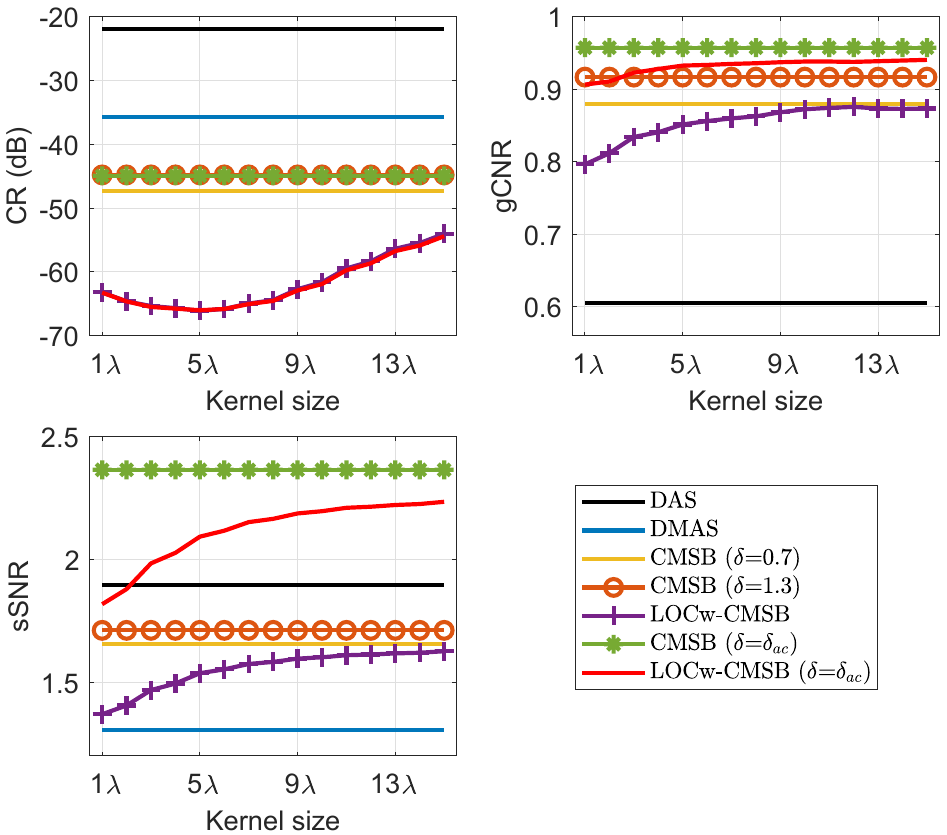
Figure 10. CR, gCNR, and sSNR of LOC-weighted methods as a function of the kernel size in the cyst phantom